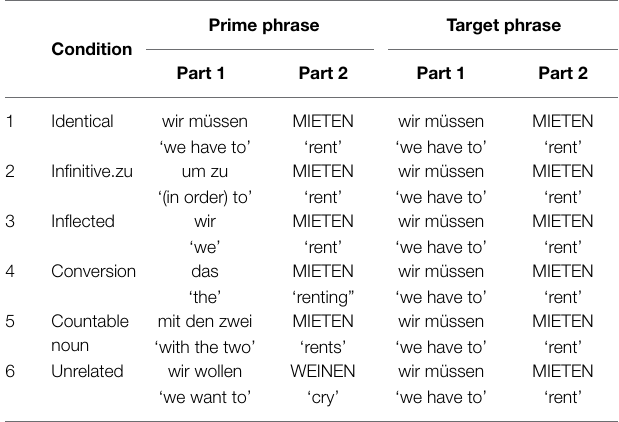
TABLE 1 | Experiment 1: experimental conditions and examples of prime and target